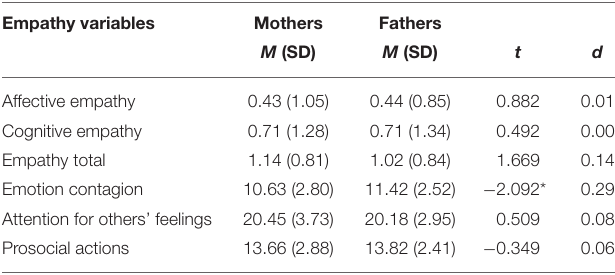
TABLE 2 | Means, standard deviations, and t -test concerning parents’ perception of children’s empathy. Empathy